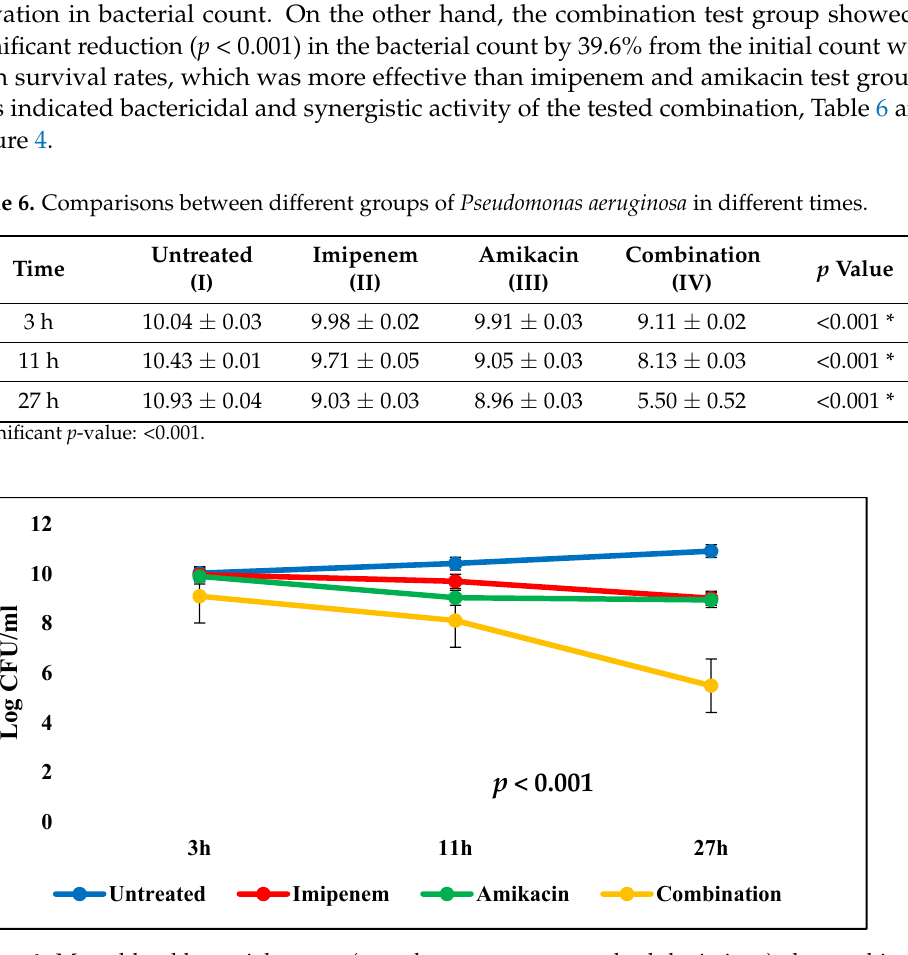
Figure 4. Mean blood bacterial counts (error bars represent standard deviations) observed in un- treated mice and in those receiving amikacin (15 mg/kg every 8 h), imipenem (40 mg/kg every 4 h), and amikacin (15 mg/kg every 8 h) plus imipenem (40 mg/kg every 4 h). p value < 0.001 indicates significant difference between the four groups.